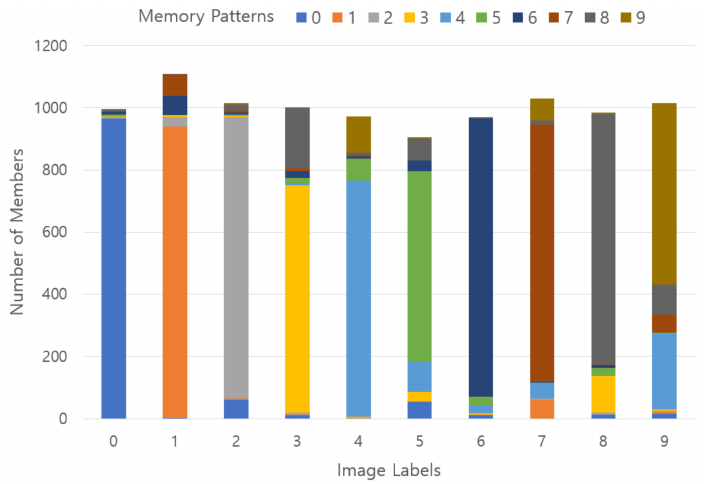
Figure 22. Results of stored memory pattern in an experiment using 20% SDR overlap with the pre-memory process; x -axis represents a ground-truth label, y -axis describes the number of members belonging to each label, and a vertical color code indicates a memory pattern ratio belonging to each ground-truth